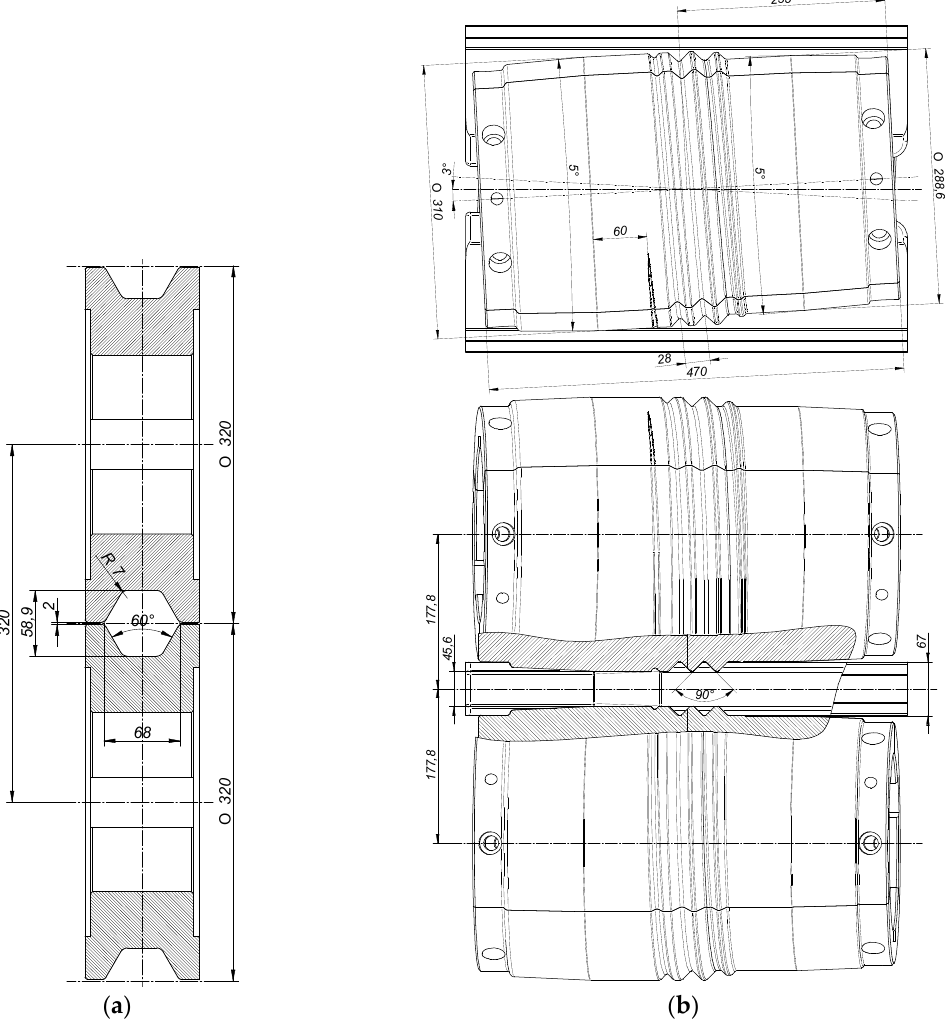
Figure 2. Design and configuration, with the dimension in mm: ( a ) grooved rolls for longitudinal rolling of a preform; ( b ) rolls with helical ribs for skew rolling of rods.